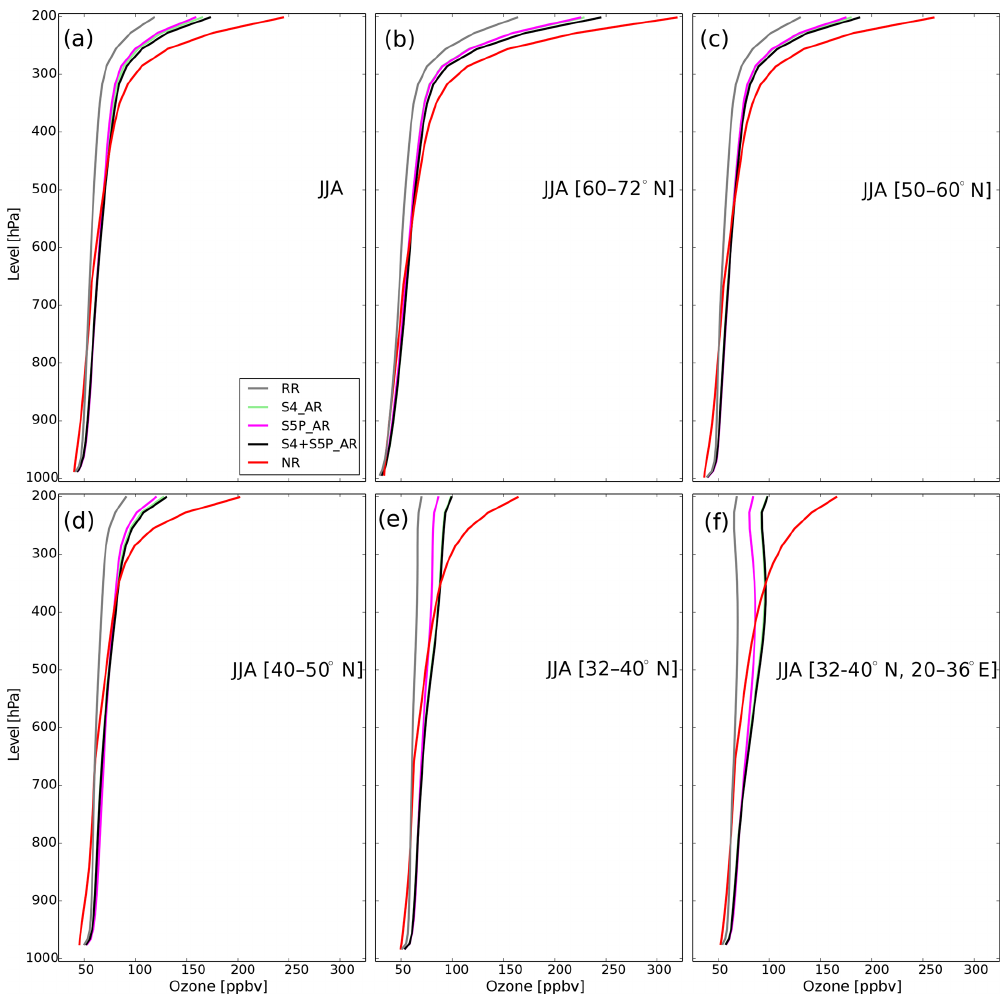
Figure 13. Ozone profiles (ppbv) averaged for the summer 2003 (JJA) by geographical zone: over the European domain and zones Z1 (60– 72 ◦ N) and Z2 (50–60 ◦ N) (top row, from left to right), and zones Z3 (40–50 ◦ N), Z4 (32–40 ◦ N), and Z4B (32–40 ◦ N, 20–36 ◦ E) (bottom row, from left to right), as simulated from the reference run (grey lines), the S4_AR (green lines), the S5P_AR (magenta lines), the S4+S5P_AR (black lines), and the nature run (red lines). These zones are identified with black boxes over Fig.